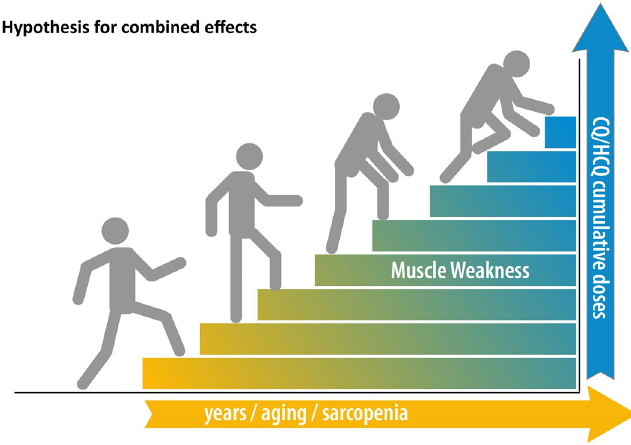
Figure 4. Hypothesis for combined effects of sarcopenia and CQ/HCQ induced myopathy along with aging and chronic use of